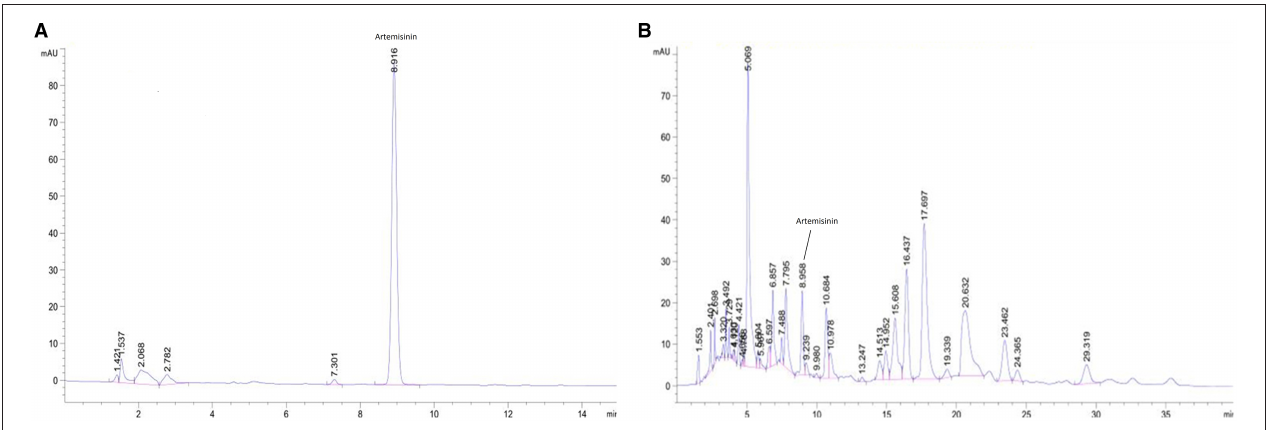
Frontiers in Veterinary Science |